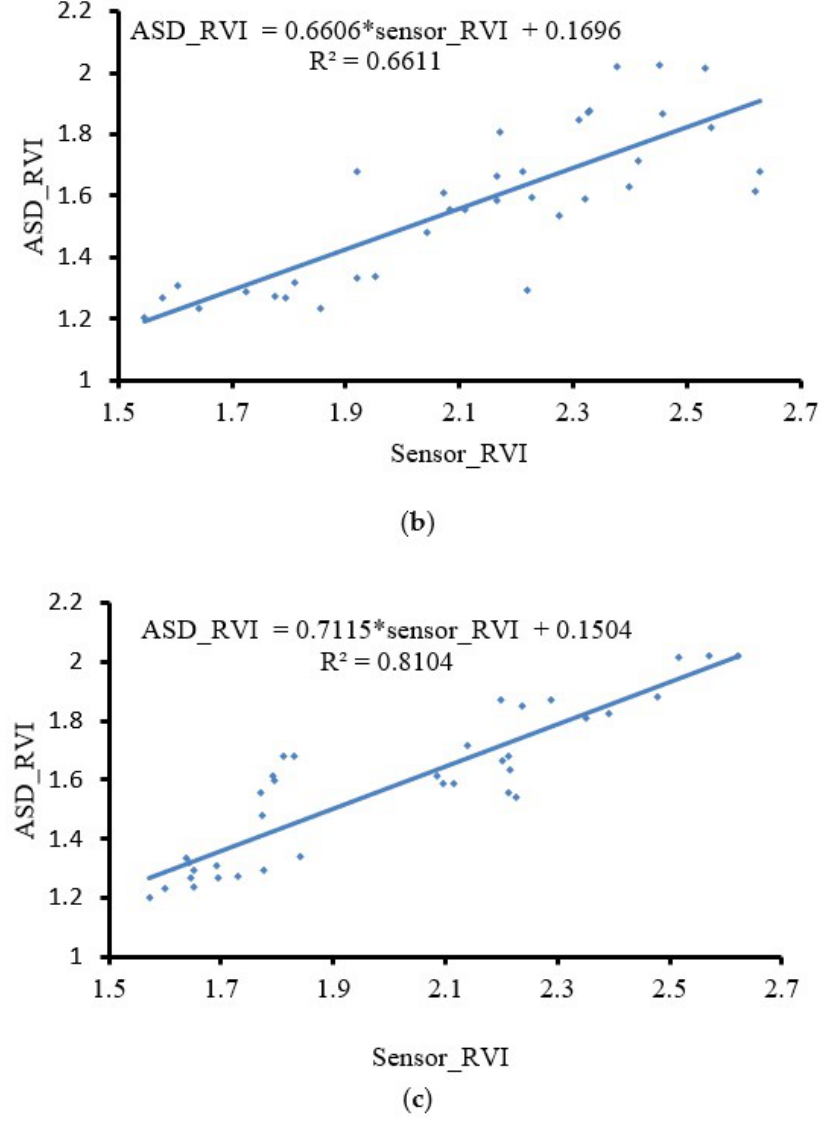
Figure 11. Fitting curves for the sensor and ASD data. ( a ) Sensor located under the UAV; ( b ) sensor located 30 cm from the rotor; ( c ) sensor located 60 cm from the